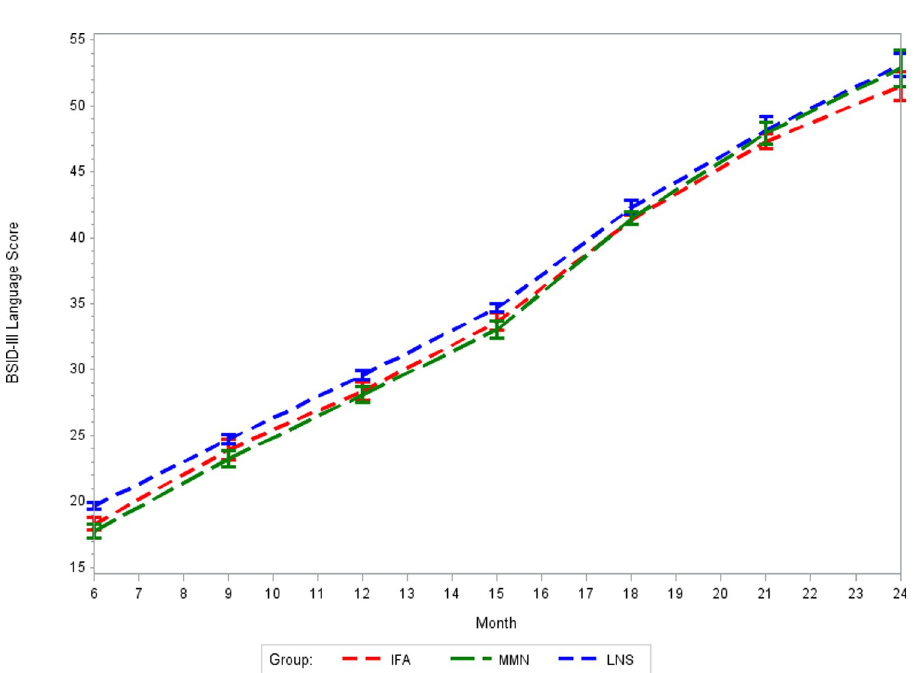
Fig 4. Mean BSID-III language scores from 6 to 24 months for MMS, LNS, and IFA groups. p -Value for difference in trajectory: MMS vs. IFA = 0.87; LNS vs. IFA = 0.60. BSID-III, Bayley Scales of Infant and Toddler Development III; IFA, iron–folic acid supplements; LNS, lipid-based nutrient supplements; MMS, multiple micronutrient supplements.